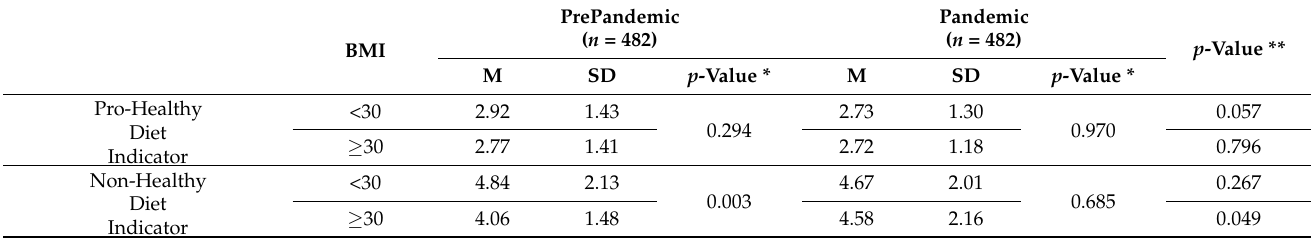
Table 7. Assessment of the effects of obesity on the quality of nutrition in the pre-pandemic and pandemic